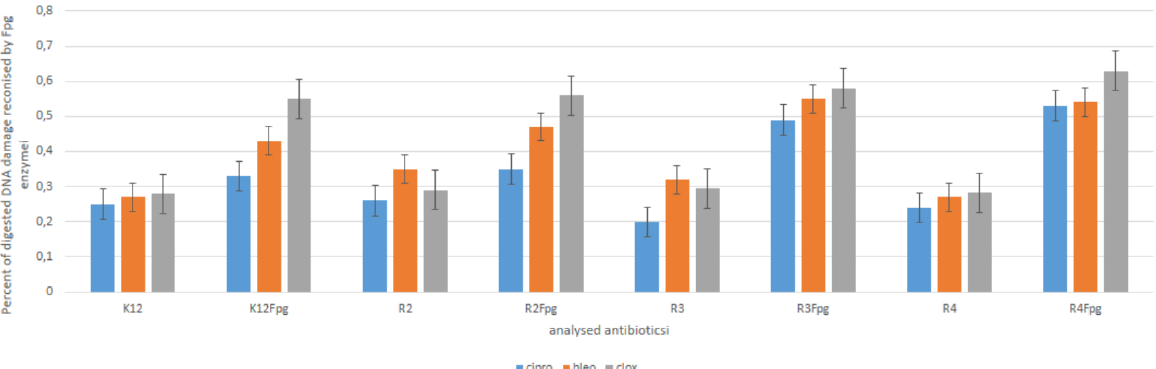
Figure 8. Percentage of bacterial DNA recognized by Fpg enzyme in model bacterial strains after ciprofloxacin, bleomycin, and cloxacillin treatment. The compounds were statistically significant at p < 0.05. Each experiment was performed independently in 3 replications ( n =